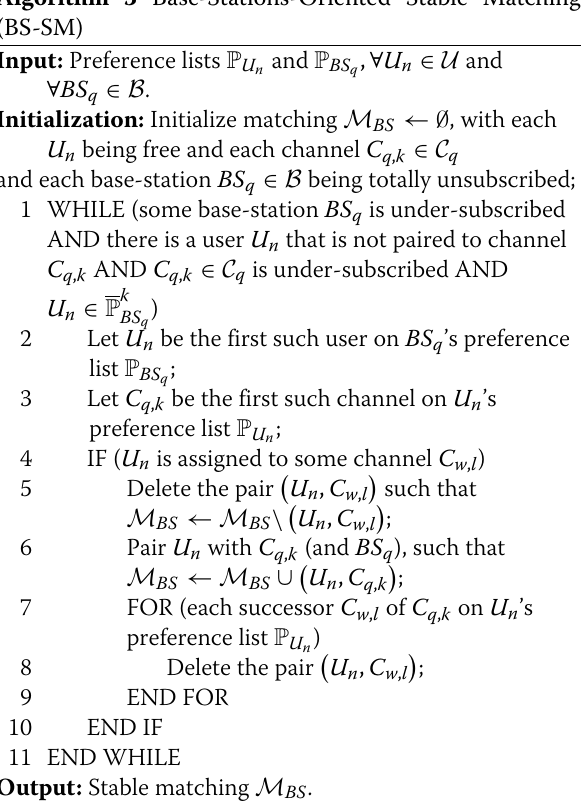
Algorithm 3 Base-Stations-Oriented Stable